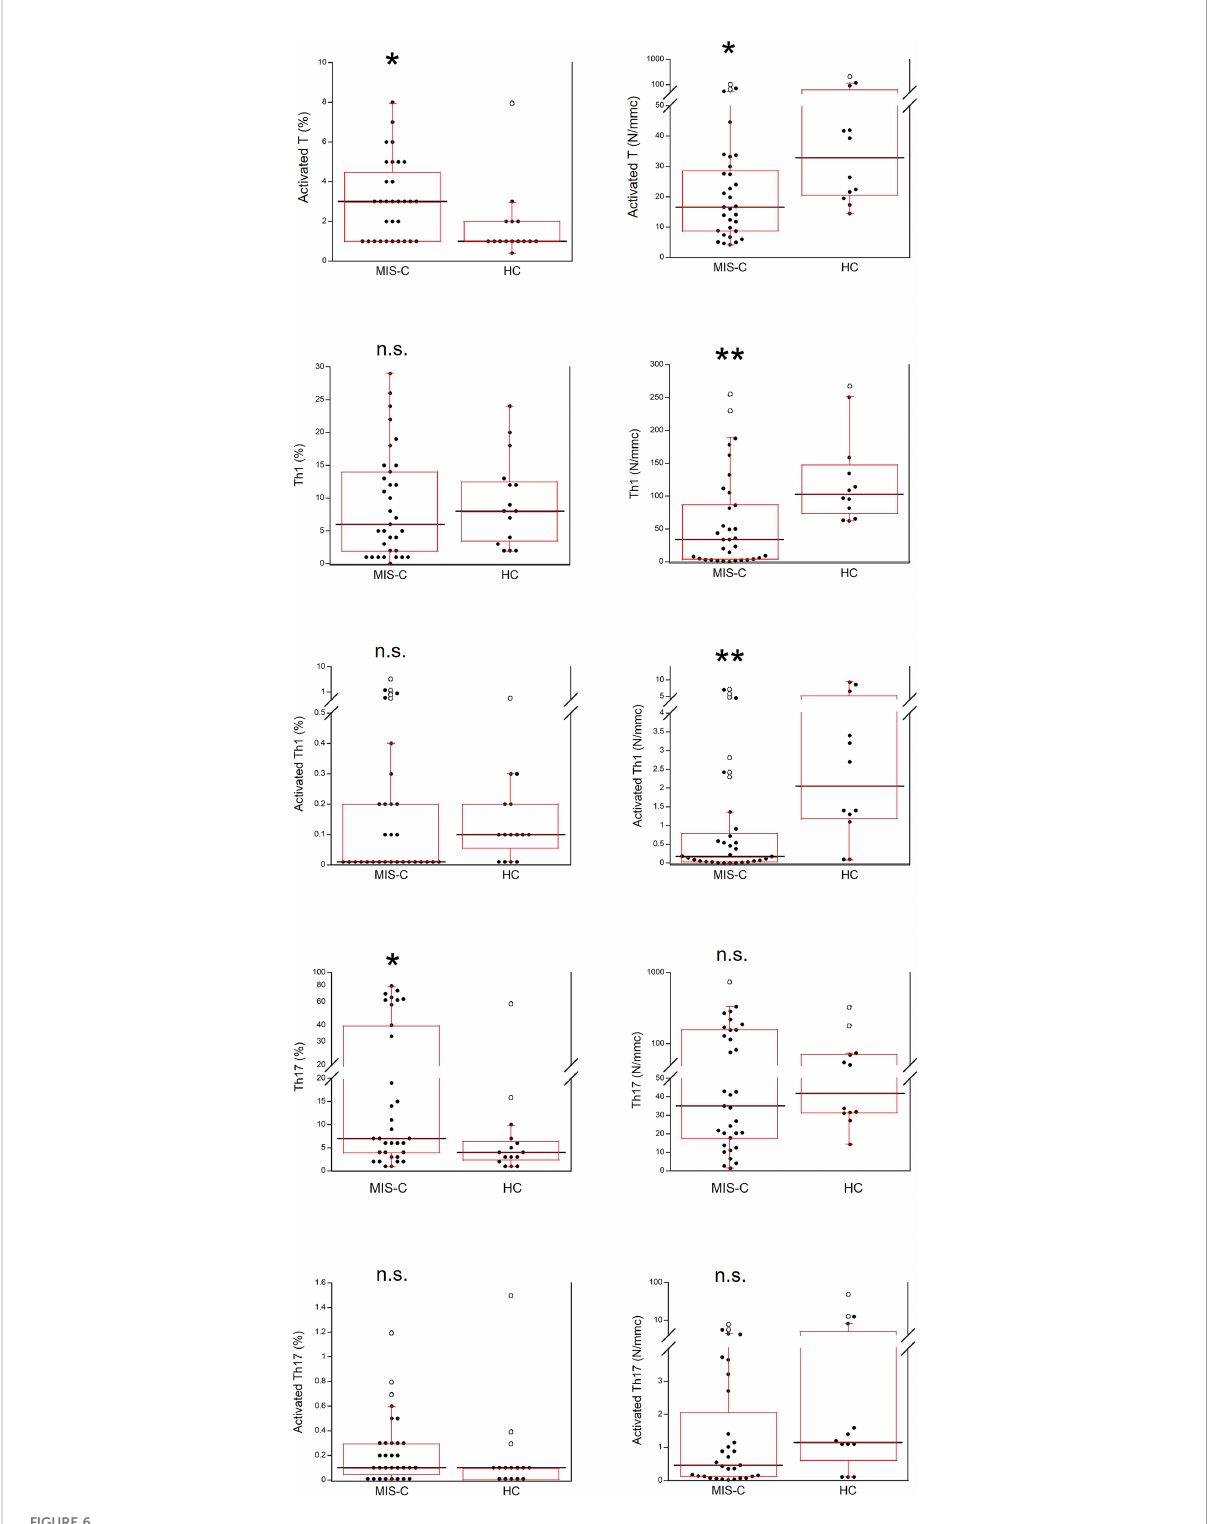
FIGURE 6 Comparison of T activated, activated Th1 and Th17 lymphocytes in 37 patients with MIS-C and in 24 HC. The black line represents the median value. The red box represents the interquartile range. The blank circles correspond to the outliers and the black circles side by side to these correspond to duplicates *p < 0.01; **p < 0.001; n.s.: not signi fi cant (p >